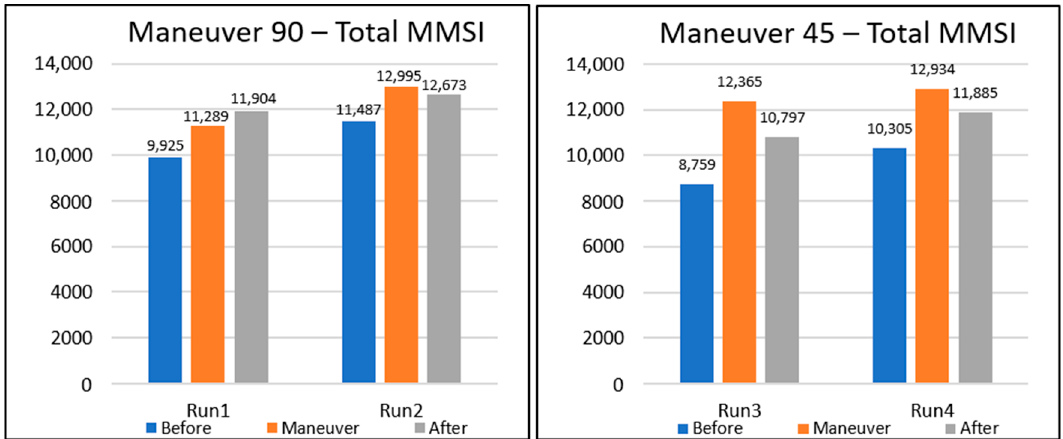
Figure 14. Comparison of unique MMSI detection performance as 45°-maneuvered and 90°- Figure14. ComparisonofuniqueMMSIdetectionperformanceas45 ◦ -maneuveredand90 ◦ -maneuvered maneuvered flight configuration applied on the satellite. flight configuration applied on the